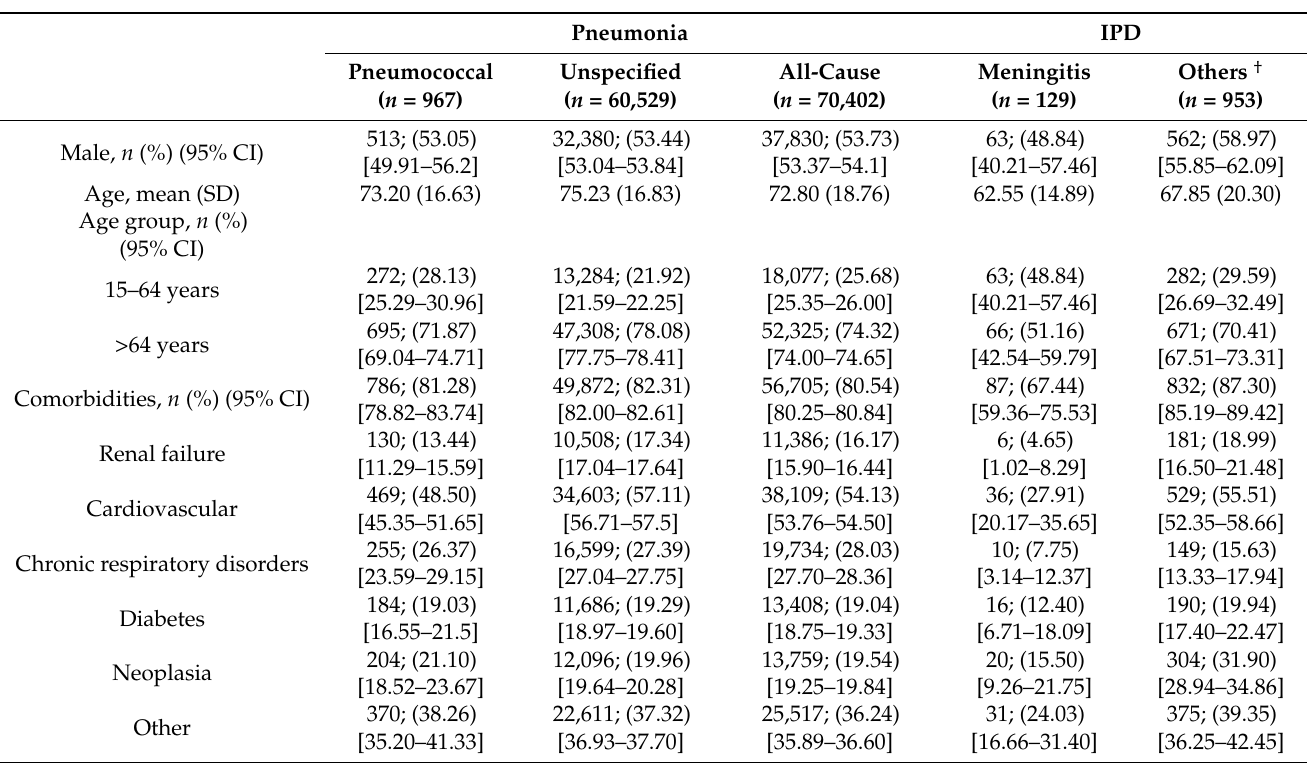
Table 2. Demographic characteristics and risk factors for invasive and non-invasive pneumonia episodes in adolescents and adults ≥ 15 years of age